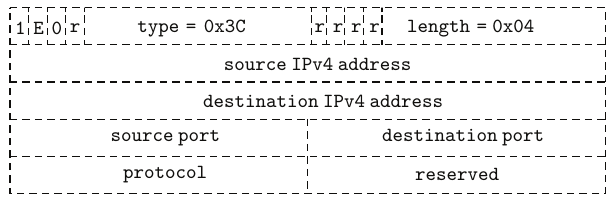
Figure 4: Reservation path parameter for